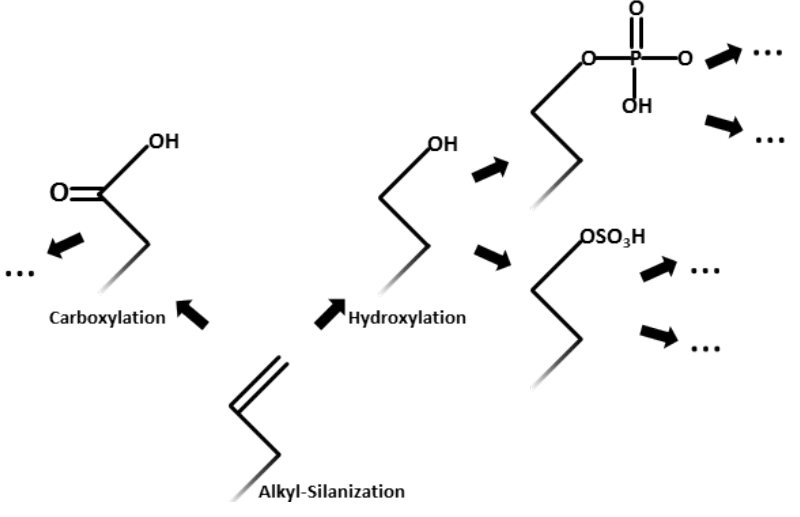
Figure 2. A selection of secondary functionalization following the alkylsilane alkene terminal groups on the surface is depicted. Note that these are only a very small selection of the applicable or even possible chemical reactions and only serve to point out the distinct potential inherent in this surface activation